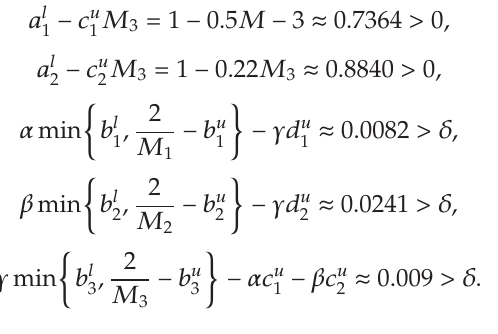
One could easily see that there exist α (cid:6) 0 . 06 , β (cid:6) 0 . 05 , γ (cid:6) 0 . 05 and δ (cid:6) 0 . 001 such